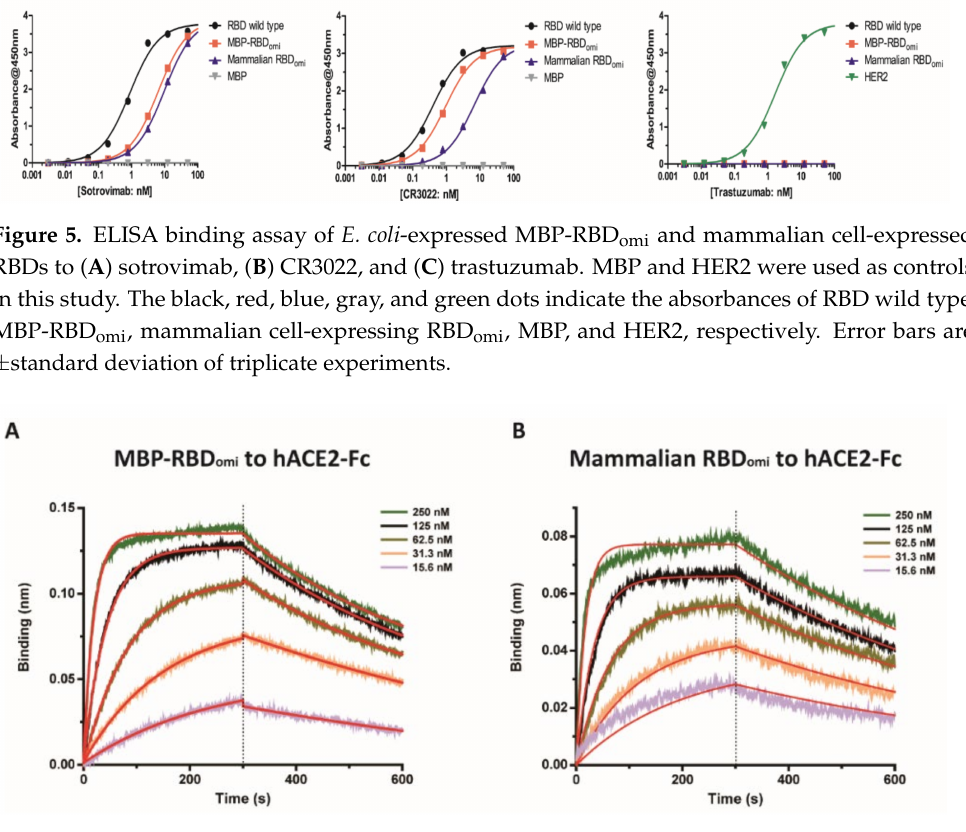
Figure 6. Binding assay of ( A ) MBP-RBD omi and ( B ) RBD omi expressed in a mammalian system to hACE2-Fc determined by BLI. Data are shown as colored lines at different concentrations of recombinant RBDs. Red lines are the best fits of the